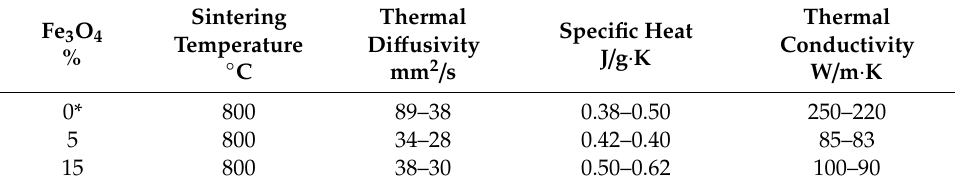
Table 2. Thermal properties of Cu-15%Fe 3 O 4 nanocomposites in the 25–900 ◦ C temperature range.